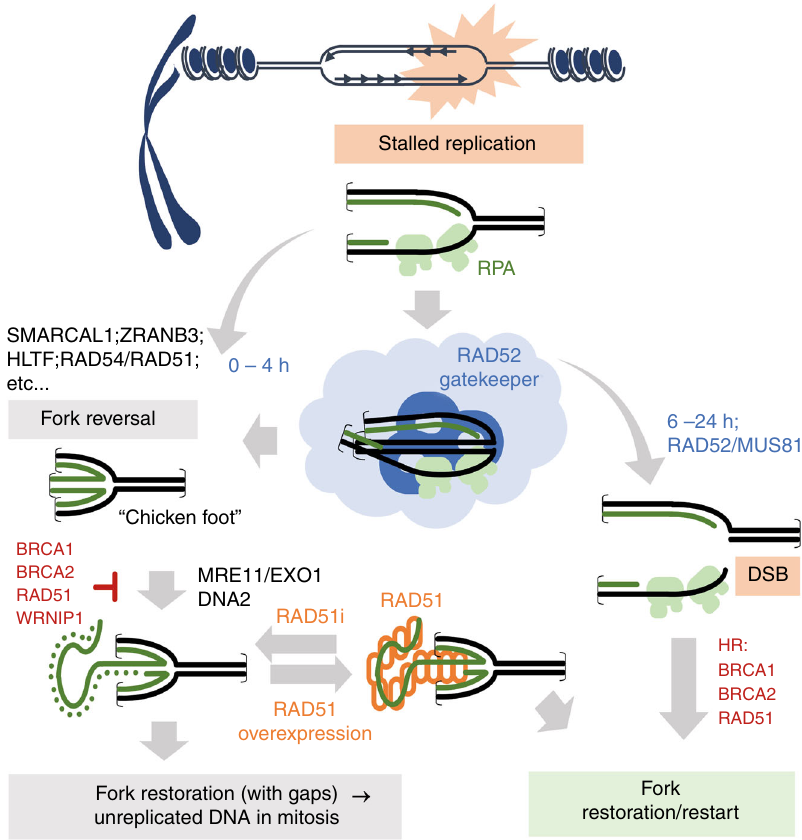
Fig. 9 Multiple roles of RAD52 at perturbed replication forks. Model representing multiple roles of RAD52 at perturbed replication forks. In response to replication fork perturbation, RAD52 plays crucial roles both upstream replication fork remodelling and downstream, when integrity of remodelled forks is undermined. The role upstream replication fork remodelling is crucial to limit reversal of replication fork, which may be deleterious if unscheduled. These two independent roles of RAD52 are carried out also through distinct protein partners, and may be relevant under either normal or pathological replication perturbation (see text for